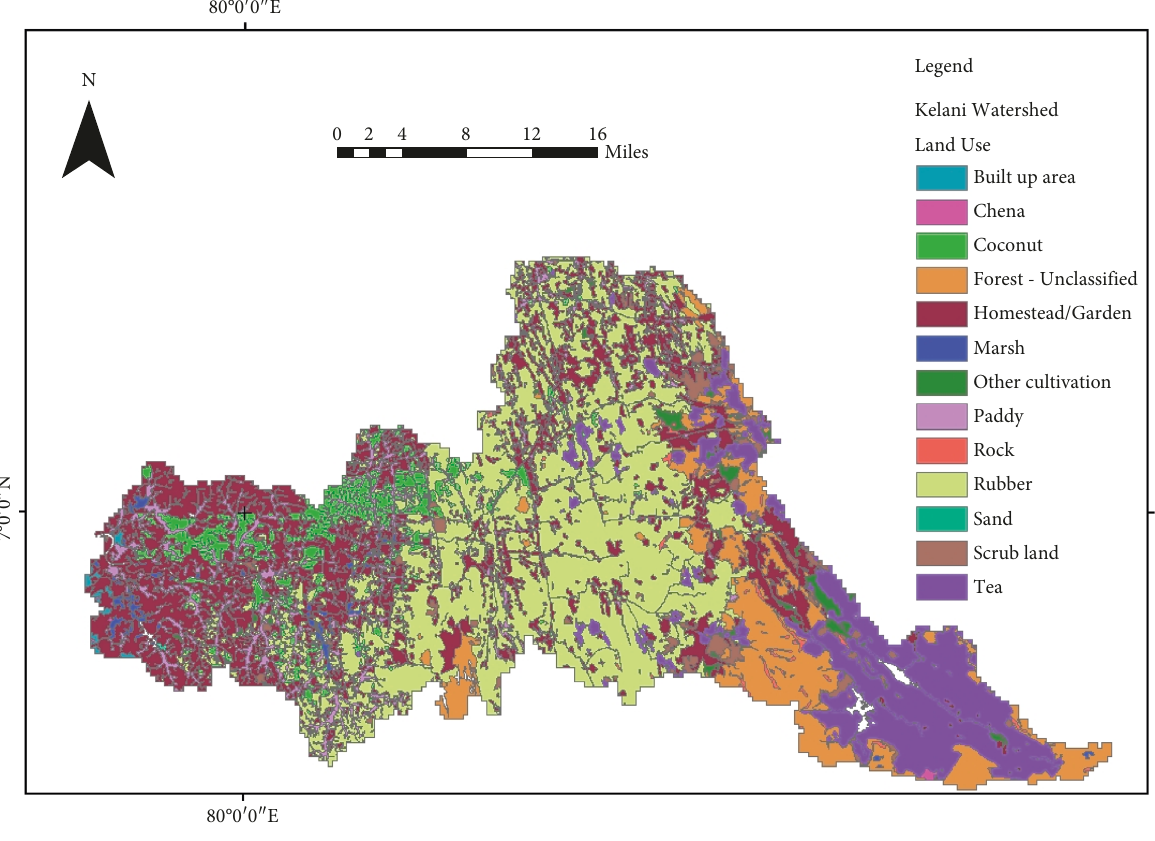
Figure 2: Land use map of Kelani river basin. Table 1: Details of observed rain gauge stations.